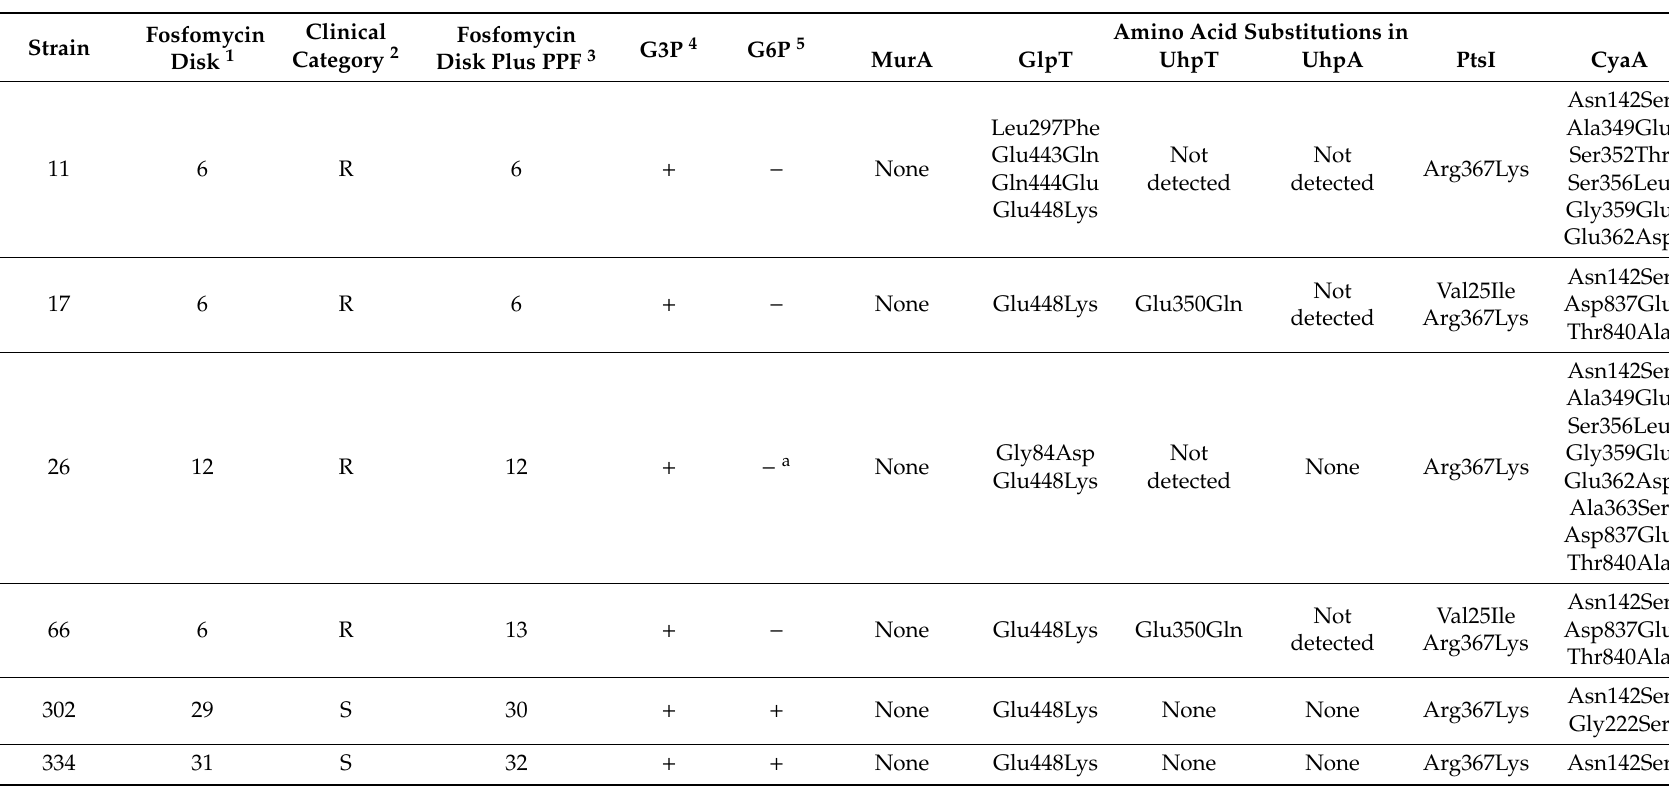
Table 2. Susceptibility to fosfomycin according to the Clinical and Laboratory Standards Institute (CLSI) procedure and supplemented with sodium phosphonoformate (PPF); bacterial growth on M9 minimal medium agar supplemented with sn -glycerol 3-phosphate (G3P) or glucose-6-phosphate (G6P); and amino acid substitutions in MurA, GlpT, UhpT, UhpA, PtsI, and CyaA proteins in 29 clinical isolates of Escherichia coli